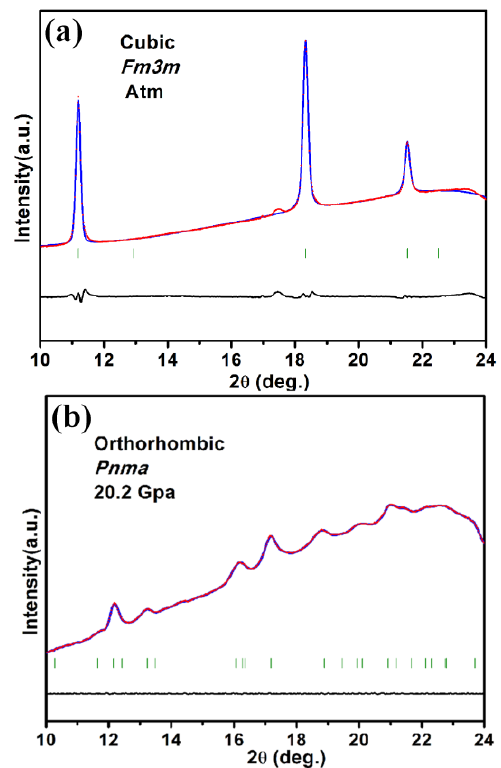
Figure 3. Refinements of the experiment (red dots), simulation (blue line), and difference (black line) ADXRD patterns of fluorite ( Fm3m ) and α-PbCl 2 -type ( Pnma ) phase: ( a ) at ambient pressure; ( b ) at 20.2 GPa. Green bars mark the positions of corresponding Bragg reflections.